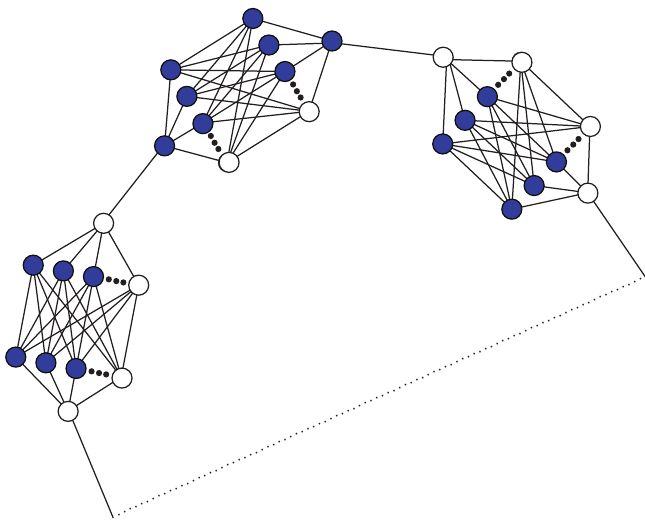
Figure 5: The jewel necklace J s , r with a zero forcing set